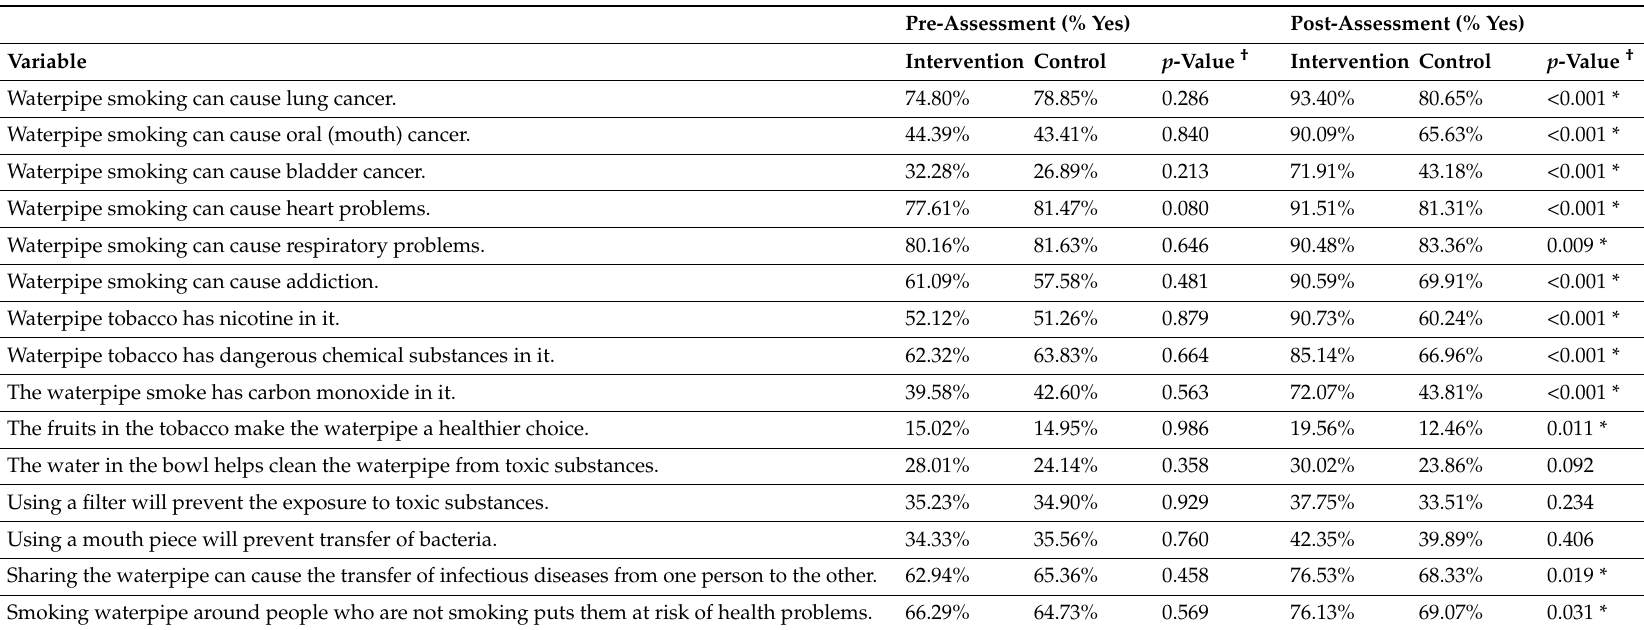
Table 2. Differences in WTS knowledge between intervention and control group participants at pre-assessment and